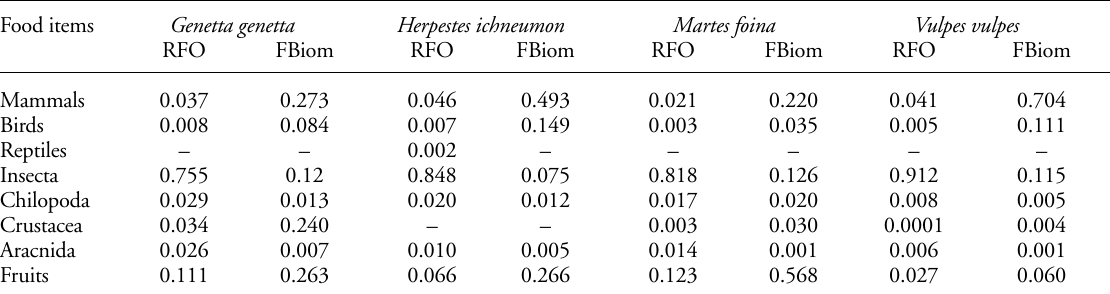
Table 1. Relative frequency of occurrence and frequency of biomass of food items consumed by common genets, Genetta genetta , Egyptian mongooses, Herpestes ichneumon , stone martens, Martes foina , and red foxes, Vulpes vulpes , at Grândola mountain (SW Portugal). RFO=Relative frequency of occurrence; FBiom=Frequency of biomass. Food items Genetta